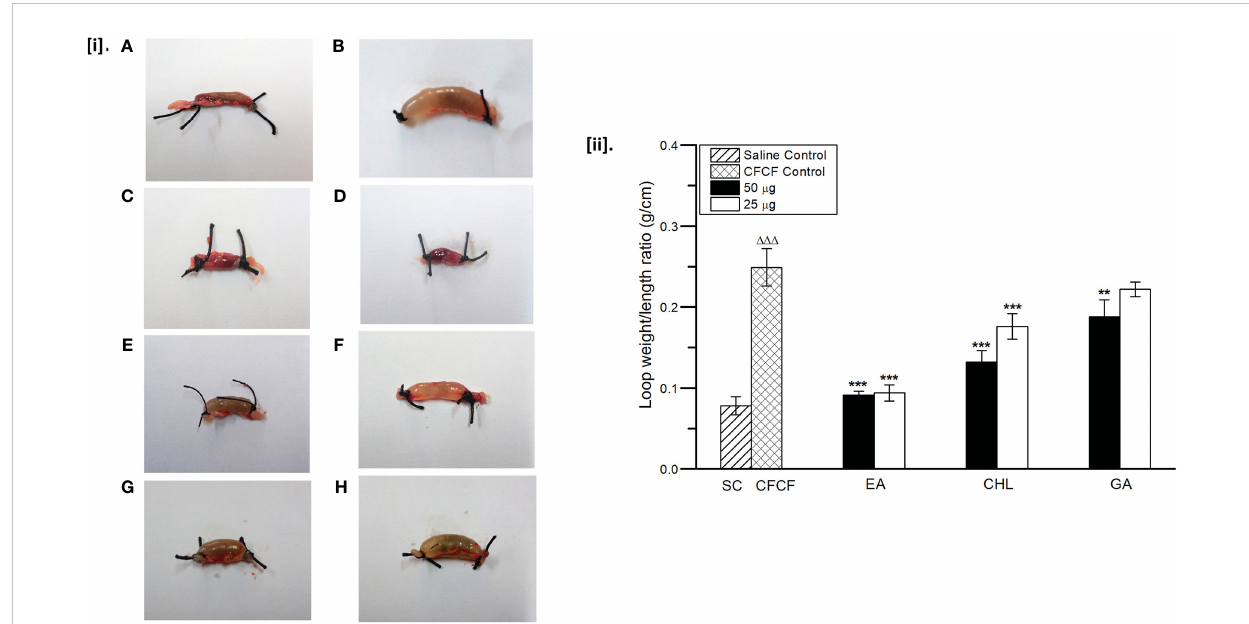
FIGURE 12 Protective activity of phenolic acids against CFCF induced fl uid accumulation. [i]. (A) Saline control (100 m l PBS), (B) CFCF control (CT=1 m g/loop), (C) EA (50 m g)+CFCF, (D) EA (25 m g)+CFCF, (E) CHL(50 m g)+CFCF, (F) CHL (25 m g)+CFCF, (G) GA (50 m g)+CFCF, (H) GA (25 m g)+CFCF. [ii] Mean W/L ratio of mice ligated-ileal loops; All values were expressed as mean ± SEM (n=6), One Way Analysis of Variance (ANOVA) followed by Dunnett test. DDD p <0.001 compared with saline control. ** p < 0.01 compared with CFCF control; *** p < 0.001 compared with CFCF control.